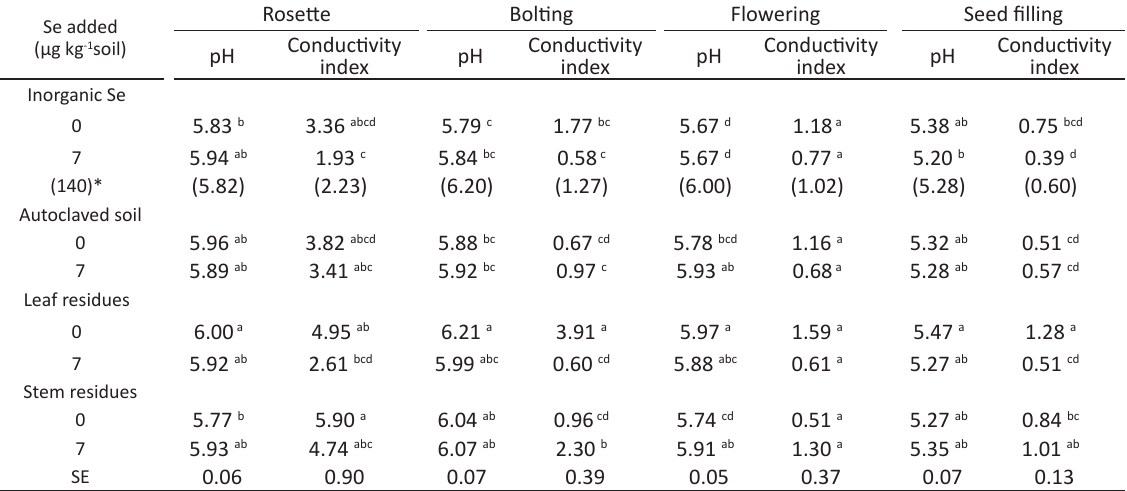
Table 7. Conductivity indices and pH of soil treated with inorganic Se (0, 7 and 140 µg kg -1 soil), organic Se (leaf and stem residue, 0 and 7 µg Se kg -1 soil) and autoclaved soil with inorganic Se (0 and 7 µg kg -1 soil) at the different growth stages Se added (µg kg -1